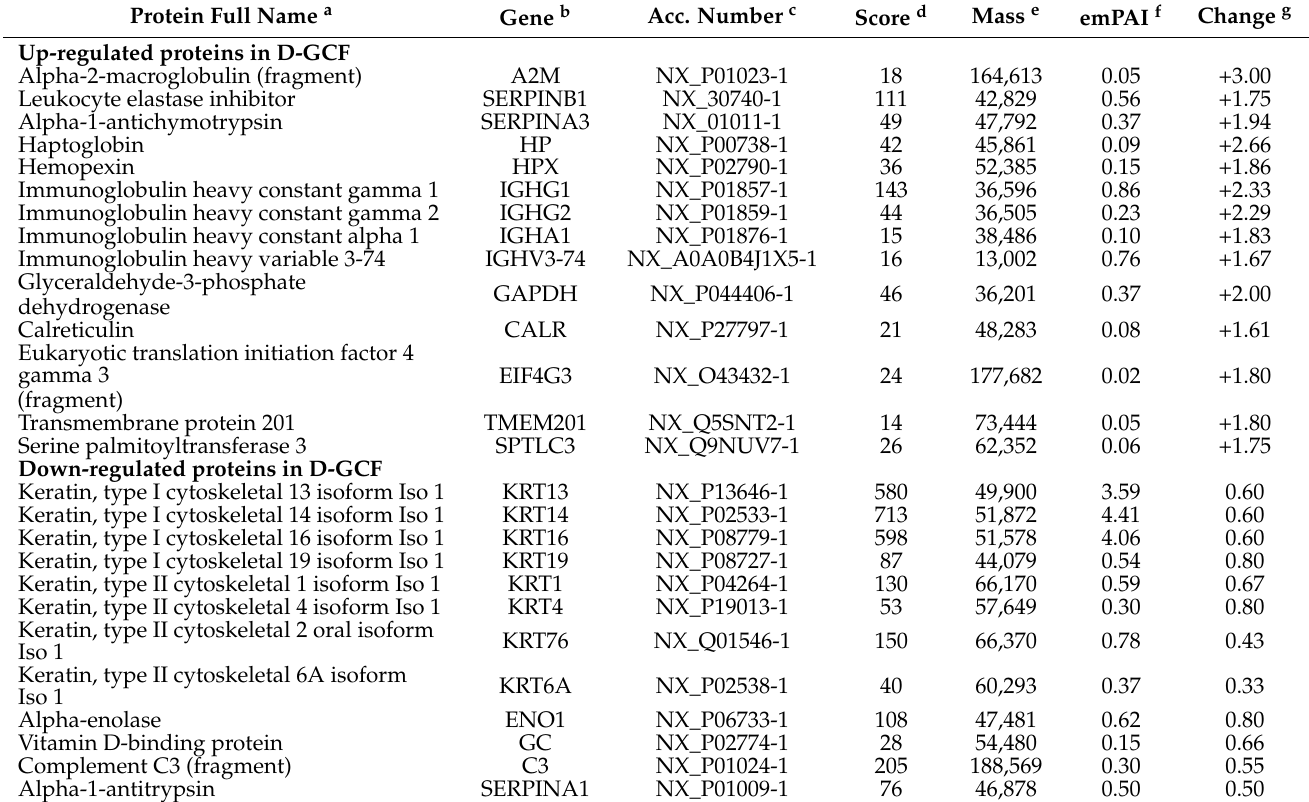
Table 1. The differentially expressed human proteins between healthy and diseased GCF. Protein Full Name